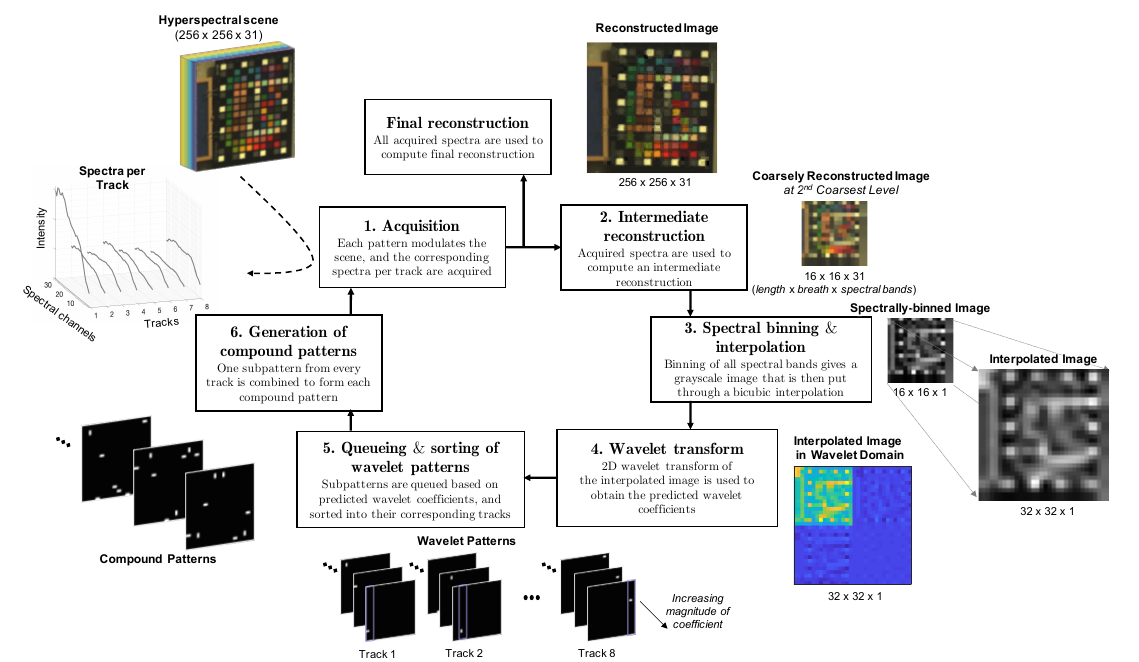
Figure 2. A flow chart of the multitrack adaptive CS scheme for hyperspectral imaging. Steps 1–6 are described briefly